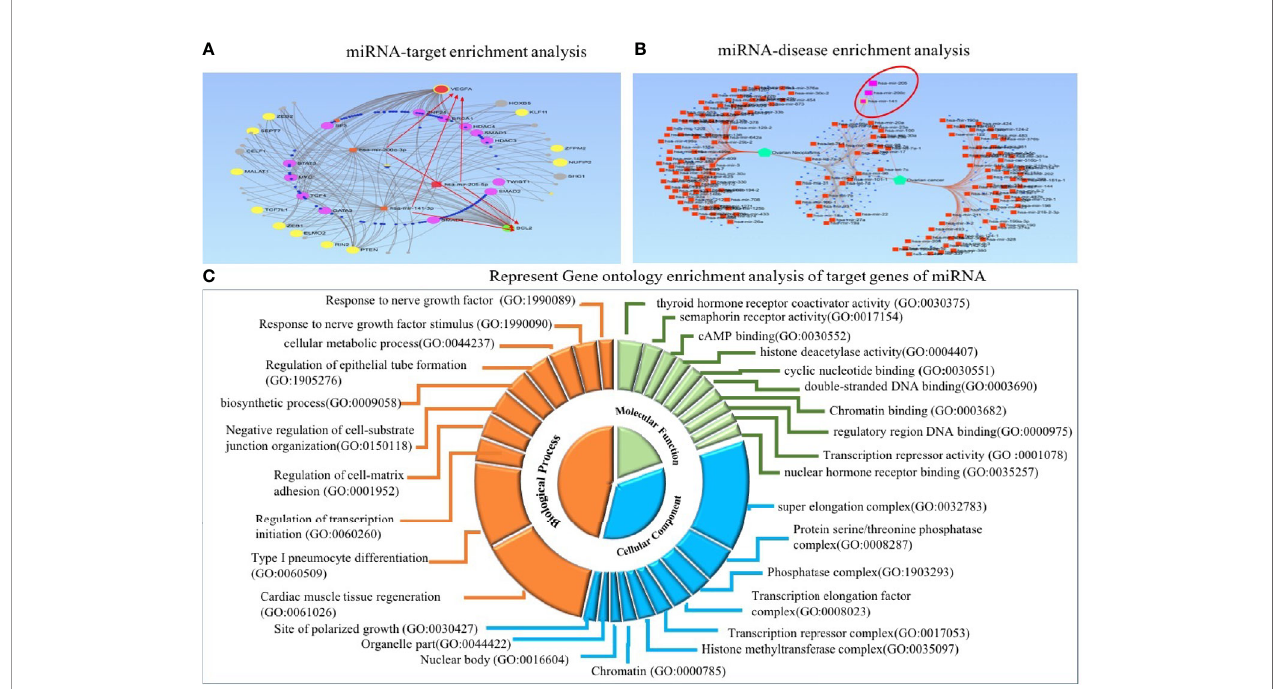
FIGURE 8 | Target enrichment and Gene Ontology enrichment analysis of miRNA – target genes. (A) In regulatory network analysis, VEGFA and BCL2 act as central target molecules of three candidate miRNAs. (B) MiRNA – disease enrichment analysis revealed candidate miRNAs were associated with ovarian cancer disease. (C) In Gene Ontology analysis, the involvement of three miRNAs in several important biological, molecular, and cellular processes was